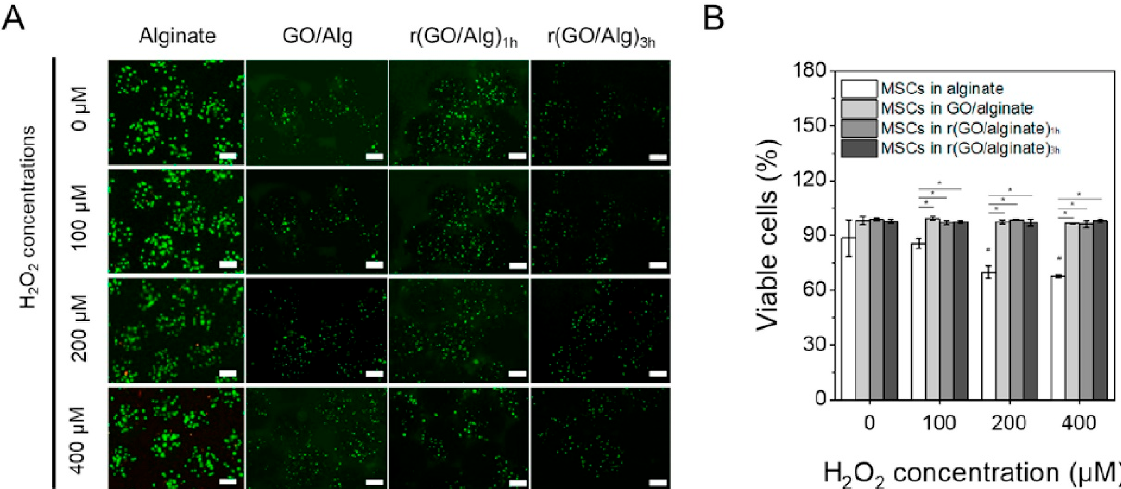
Figure 7. Human MSCs interactions with numerous types of microgels, i.e., Alginate, GO/Alg, rGO/Alg (1 h) and rGO/Alg (3 h). ( A ) Screening of stains at various H 2 O 2 concentrations, ( B ) the microgels’ percentage content incubated in MCSc using different H 2 O 2 concentrations, where existed a remarkable transformation (* p < 0.05) [124].